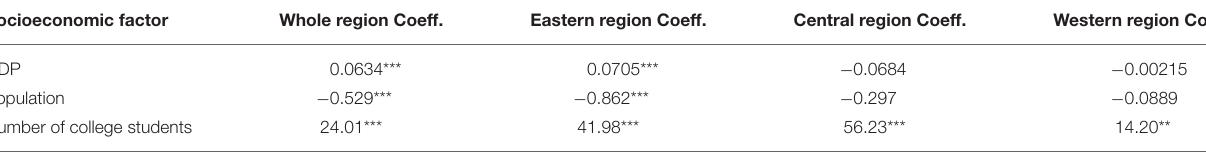
TABLE 4 | Results of the panel data regression analysis for different variables. Socioeconomic factor Whole region Coeff. Eastern region Coeff. Central region